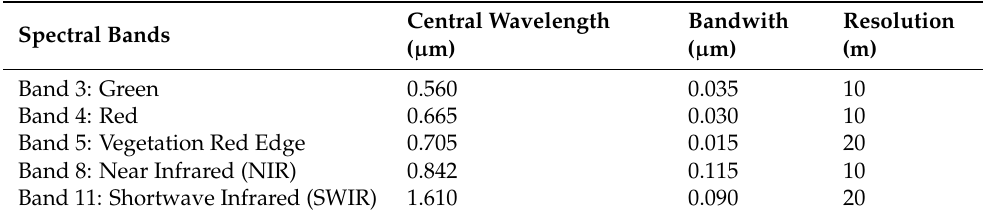
Table 1. Sentinel-2 multispectral bands used for the analysis.